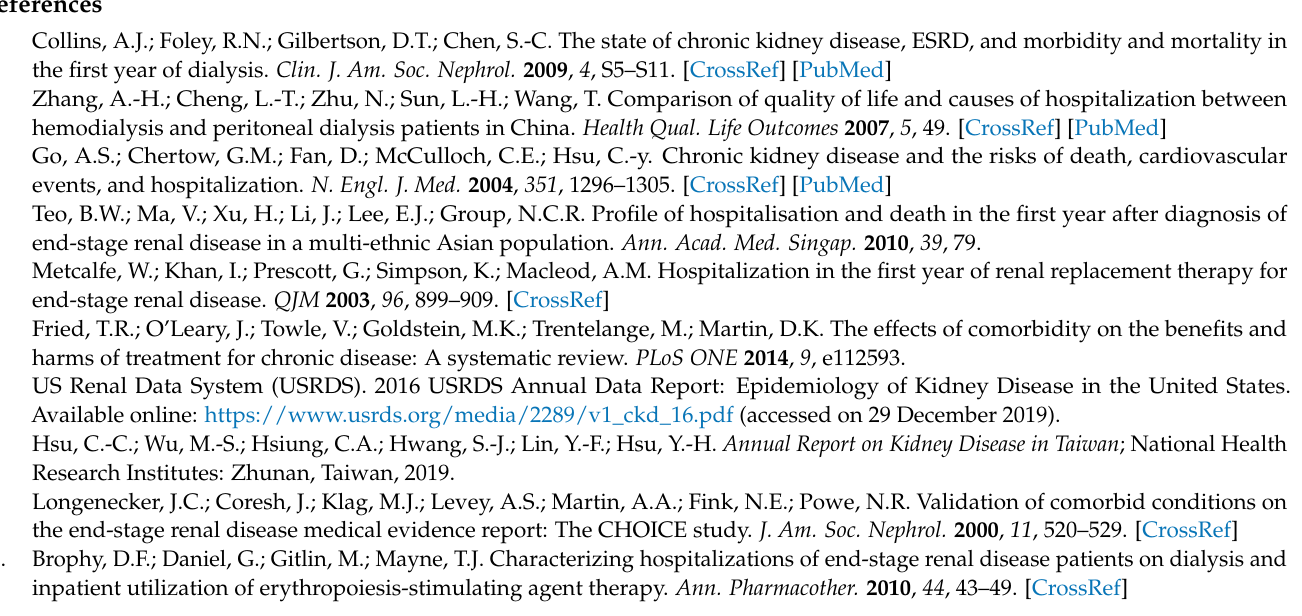
Table S4. Characteristics of patients diagnosed with native atherosclerosis by group. Table S5. Char- acteristics of patients diagnosed with urinary tract infection by group. Table S6. Characteristics of patients diagnosed with gastric ulcer by group. Table S7. Characteristics of patients diagnosed with pneumonia by group. Table S8. Characteristics of patients diagnosed with reflux esophagitis by group. Table S9. Characteristics of patients diagnosed with duodenal ulcer by group. Table S10. Characteristics of patients diagnosed with hyperkalemia by group. Table S11. Characteristics of patients diagnosed with bacteremia by